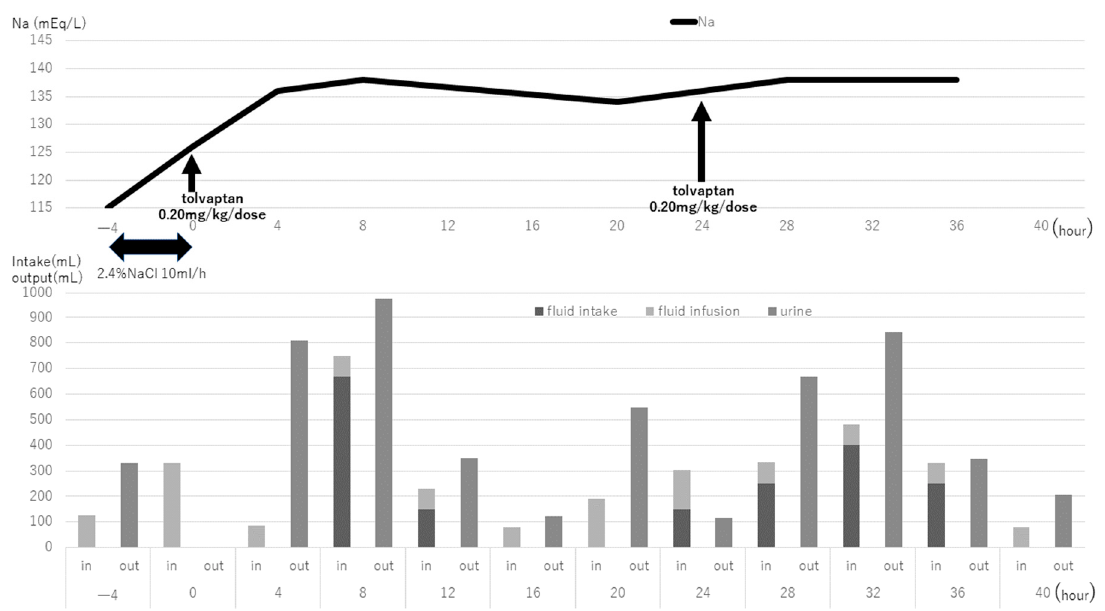
Figure 2. Changes in serum sodium levels and water intake and urine output after use of tolvaptan. The data in the bottom panel show the in-out balance data every 4 h.